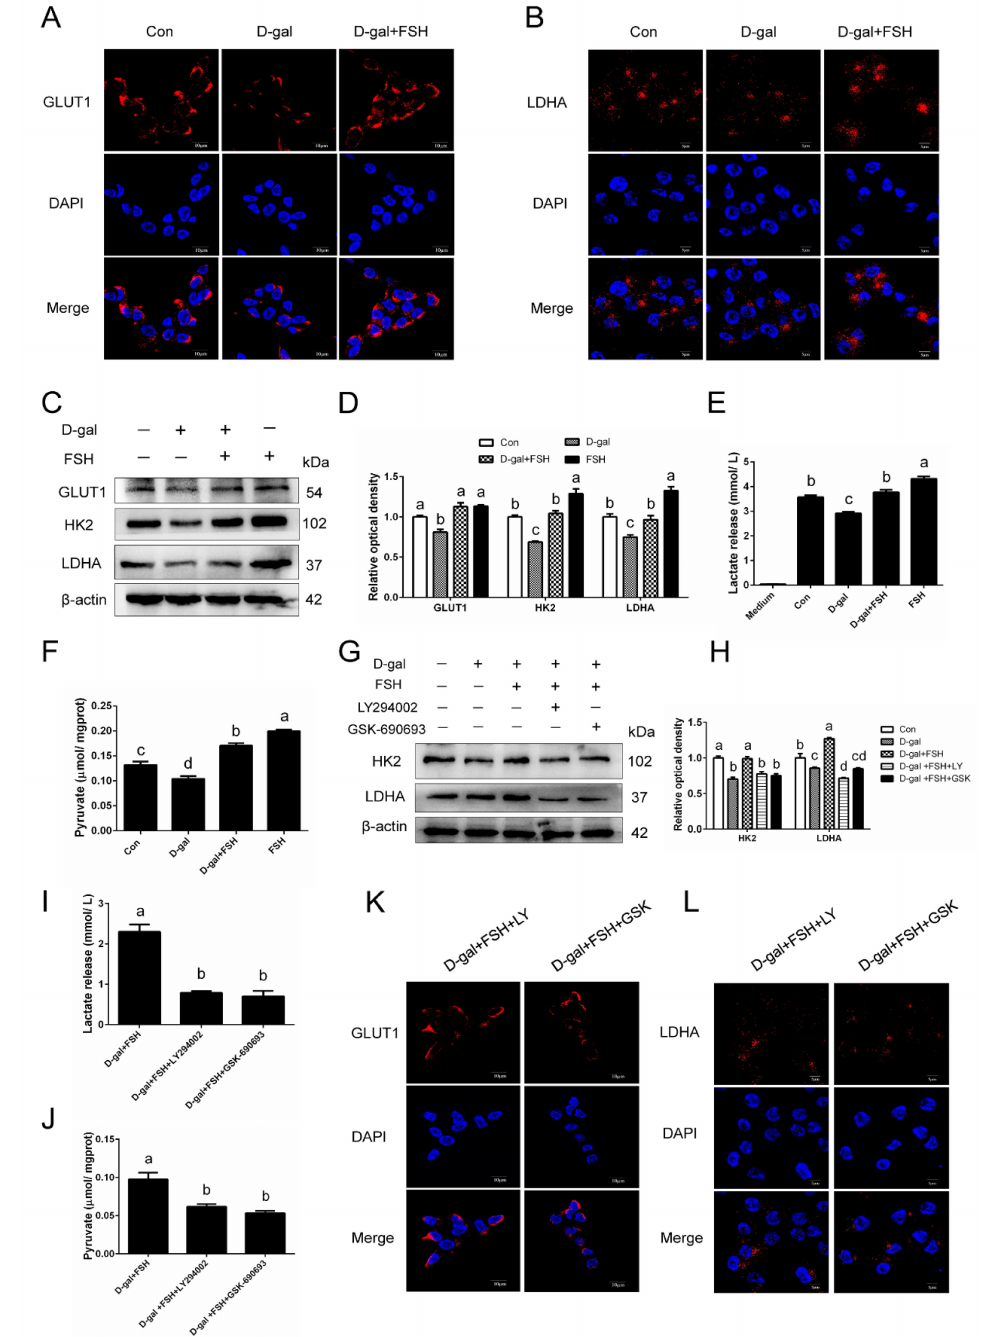
Figure 7. The enhanced effect of FSH on glycolysis in D-gal-induced senescent GCs. ( A , B ) The immunostaining of GLUT1 and LDHA in control cells, senescent cells (D-gal), and senescent cells under FSH treatment (D-gal + FSH). Scale bars: 10 µ m and 5 µ m. ( C , D ) Western blot of the glycolysis proteins of GLUT1, HK2, and LDHA in GCs exposed to D-gal for 24 h or treated with D-gal for 24 h and then cultured with FSH for another 24 h. ( E , F ) The pyruvate production and lactate release in GCs from the control, D-gal, D-gal + FSH, and FSH alone groups. ( G , H ) Levels of HK2 and LDHA in GCs treated with D-gal, D-gal + FSH, D-gal + FSH + LY294002, and D-gal + FSH + GSK690693 were detected by Western blotting. ( I , J ) Pyruvate production and lactate release shown in senescent GCs under FSH treatment, FSH + LY294002, and FSH + GSK690693. ( K , L ) Observation of GLUT1 and LDHA staining in senescent GCs that were treated as described above. Scale bars: 10 µ m and 5 µ m. Different lowercase letters present significant differences ( p <